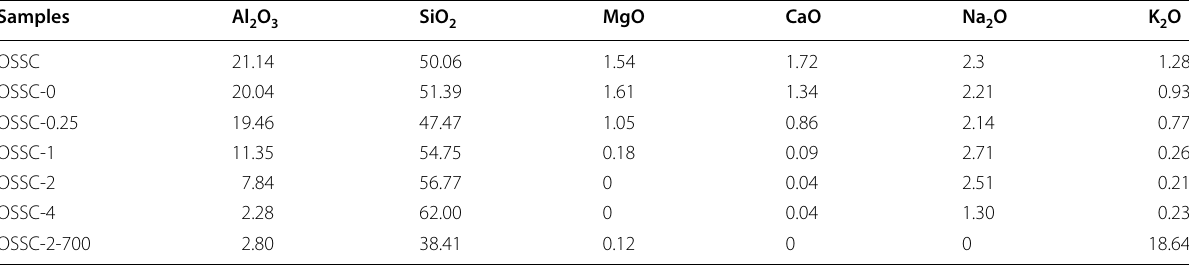
Table 1 XRF chemical compositions (wt.%) of raw OSSC and OSSC-X Samples Al 2 O 3